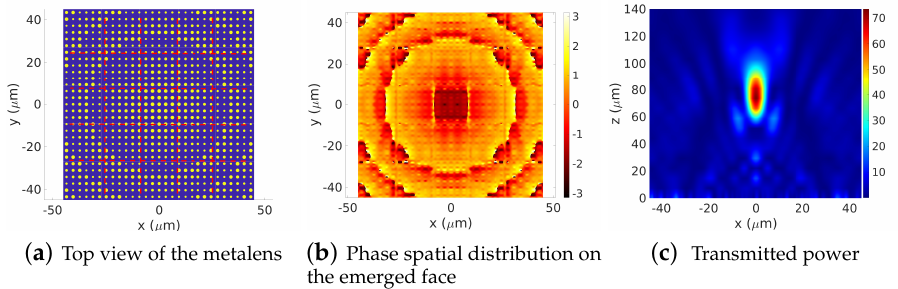
Figure 10. Forward simulation of a metalens consisting of sub-wavelength dielectric nanorodes with different cross-section. Power distributions of the focusing spot in the ( x , y = 0, z ) plane, λ = 7 µ m, z s = 10 λ , domain Ω = 12.8571 λ × 12.8571 λ = 5 × 5 sub-cell Ω ij , h = 5.57 µ m, materials: dielectrics Si ν = 3.6082 deposited on material with refractive index 2.4626, m x = m y = 10, M x = M y =